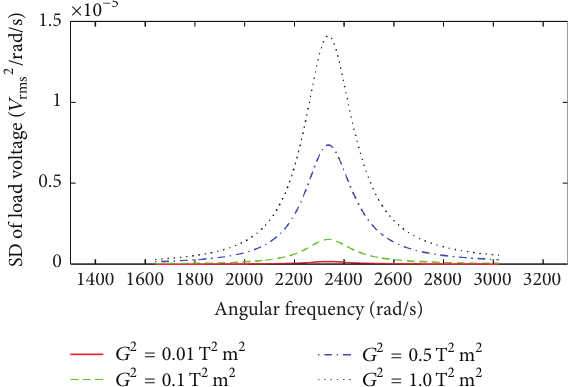
Figure 7: SD of the load voltage as a function of angular frequency for various values of 𝐺 2 at band-limited random excitation.